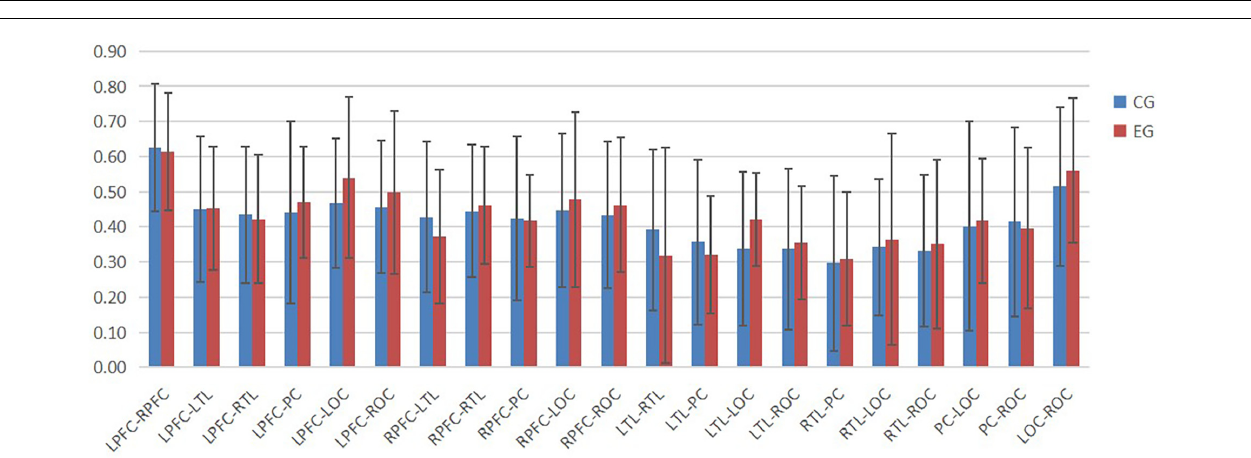
FIGURE 4 | The ROI connection strength for control and cognitive impairment groups of Task 1.